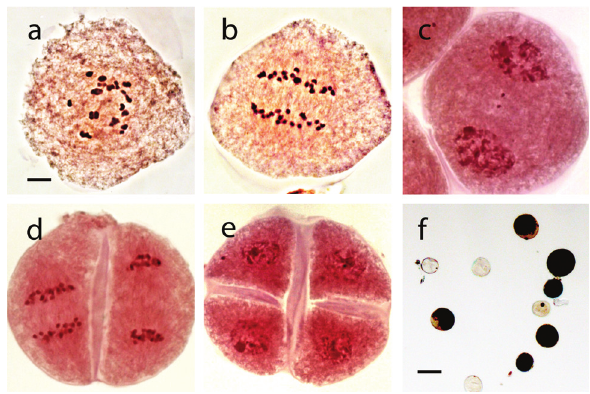
Figure 2 - Male gametophyte development in Paspalum modestum . (a-e) Progression of male meiosis through different cellular stages: metaphase I (a) showing 1 I + 10 II + 1 III + 4 IV chromosome associations, anaphase I (b), telophase I (c), anaphase II and telophase II (d), and tetrad (e). (f) Ma- ture male gametophytes at blooming. The scale bar in a-e represents 10 (cid:3) m, and in f represents 100 (cid:3) m.